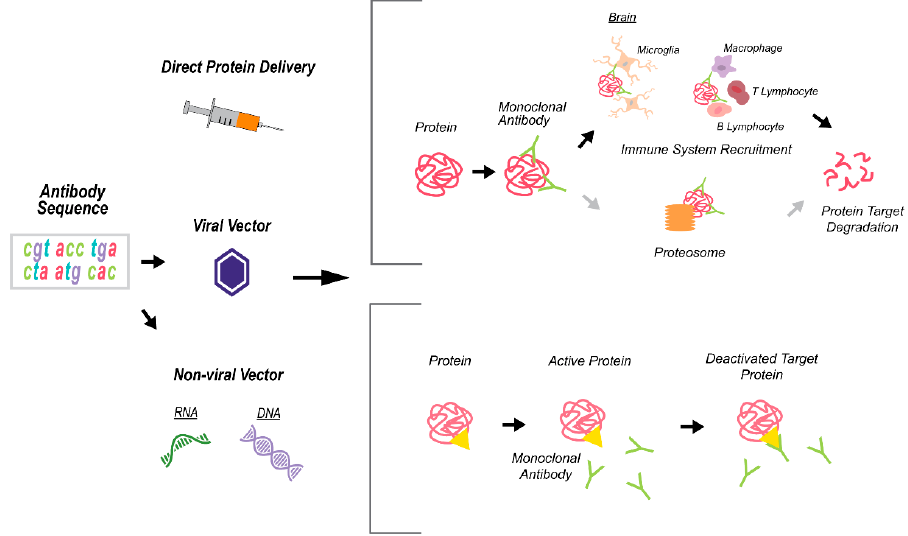
Figure 4. A schematic depicting the monoclonal antibody (mAb) technology for immunotherapies. Antibody delivery is done directly or through viral or non-viral vectors that contain the antibody sequence. The mAb specifically recognizes the target protein/s and exerts its effects via blocking the protein function (e.g., yellow triangle represents the ligand-receptor binding site) or by recruiting the immune system and activating protein degradation pathways.